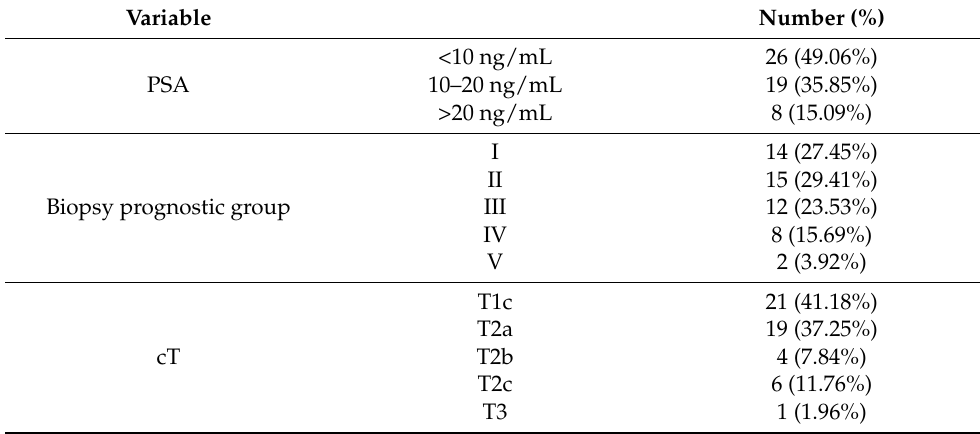
Table 2. Baseline characteristics of the cohort used for immunohistochemistry validation.